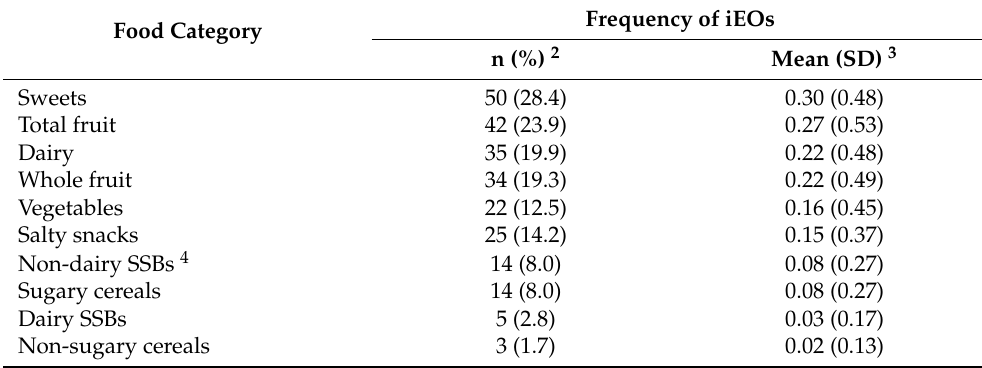
Table 4. Frequency of foods consumed by food category during independent eating occasions (iEOs) among participants (10–13 years) 1